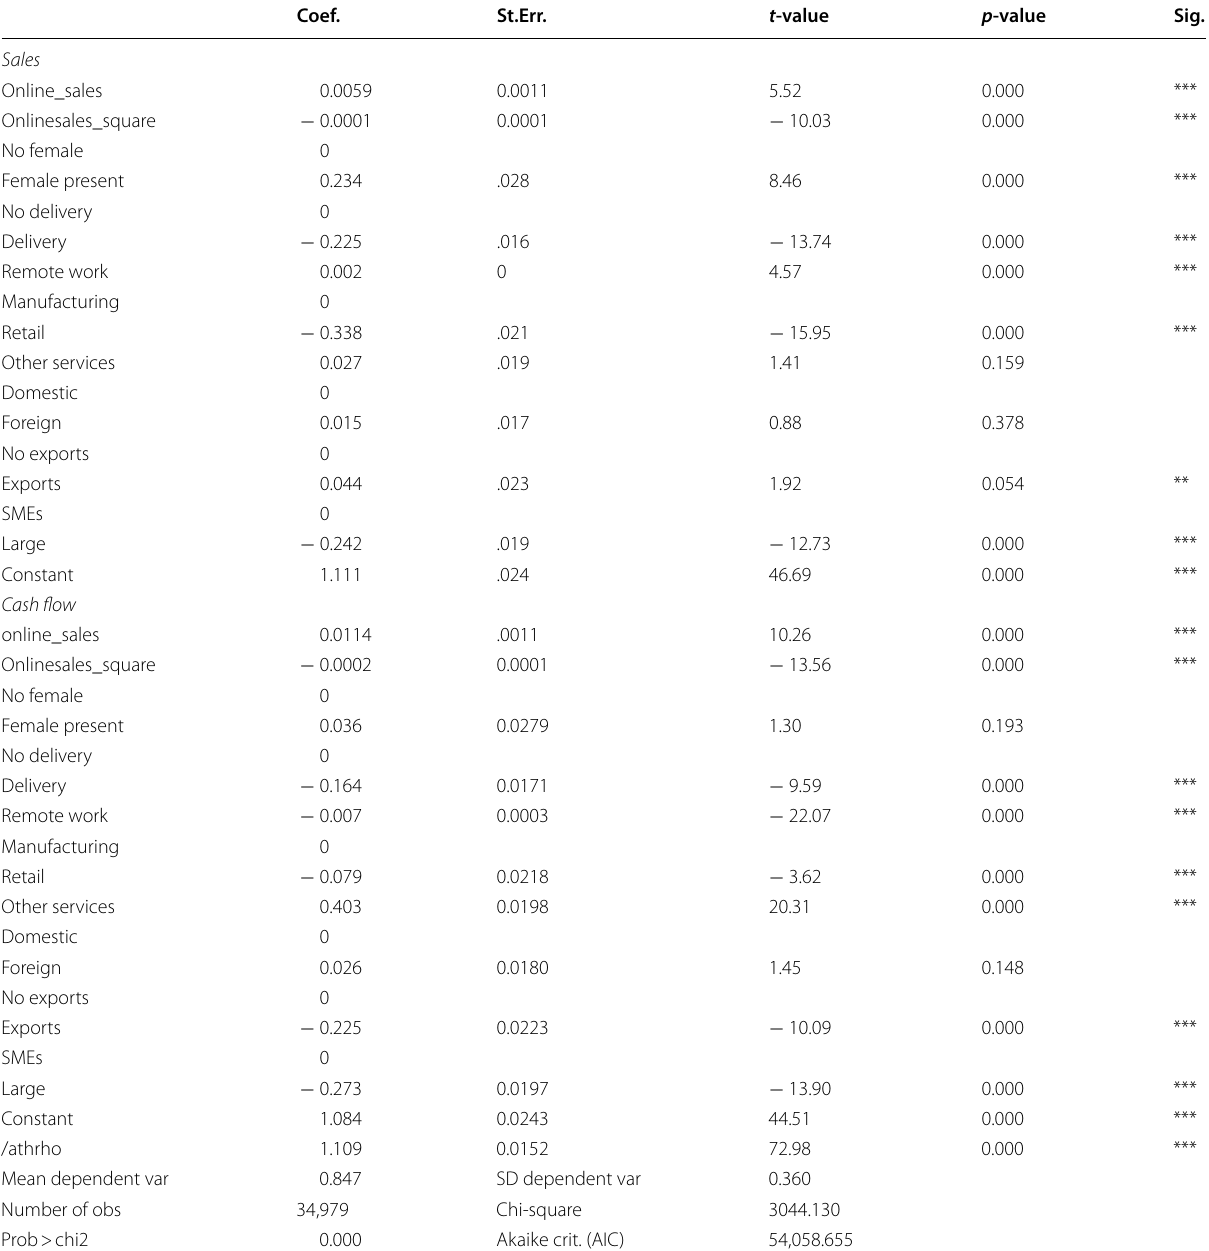
Table 2 Bi-probit model of sales and cash-flow decline and their correlates. Source : authors’ construct based on Covid-19 ES follow-up survey